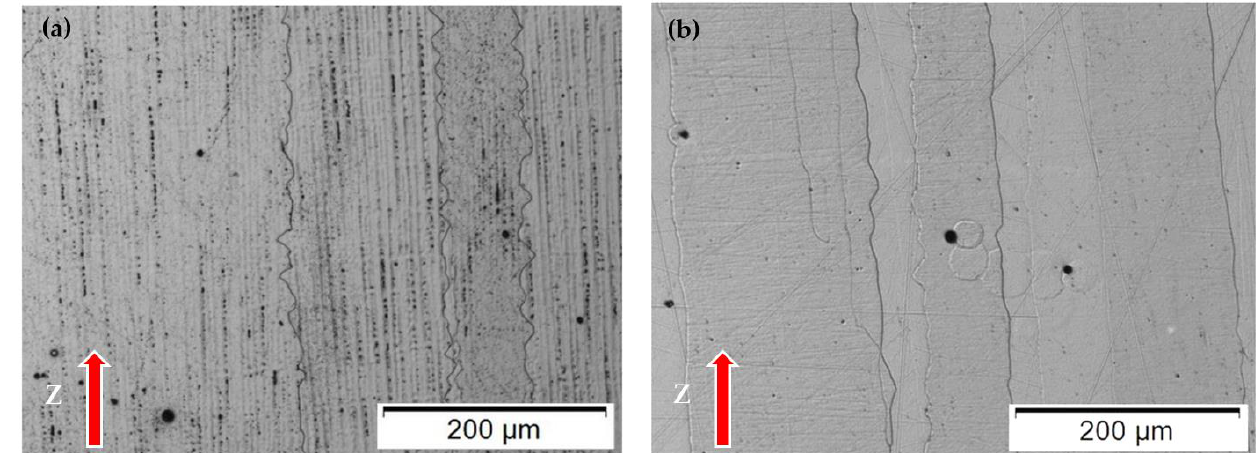
Figure 7. EB-PBF optical microscope images: ( a ) as-built, ( b ) heat-treated.